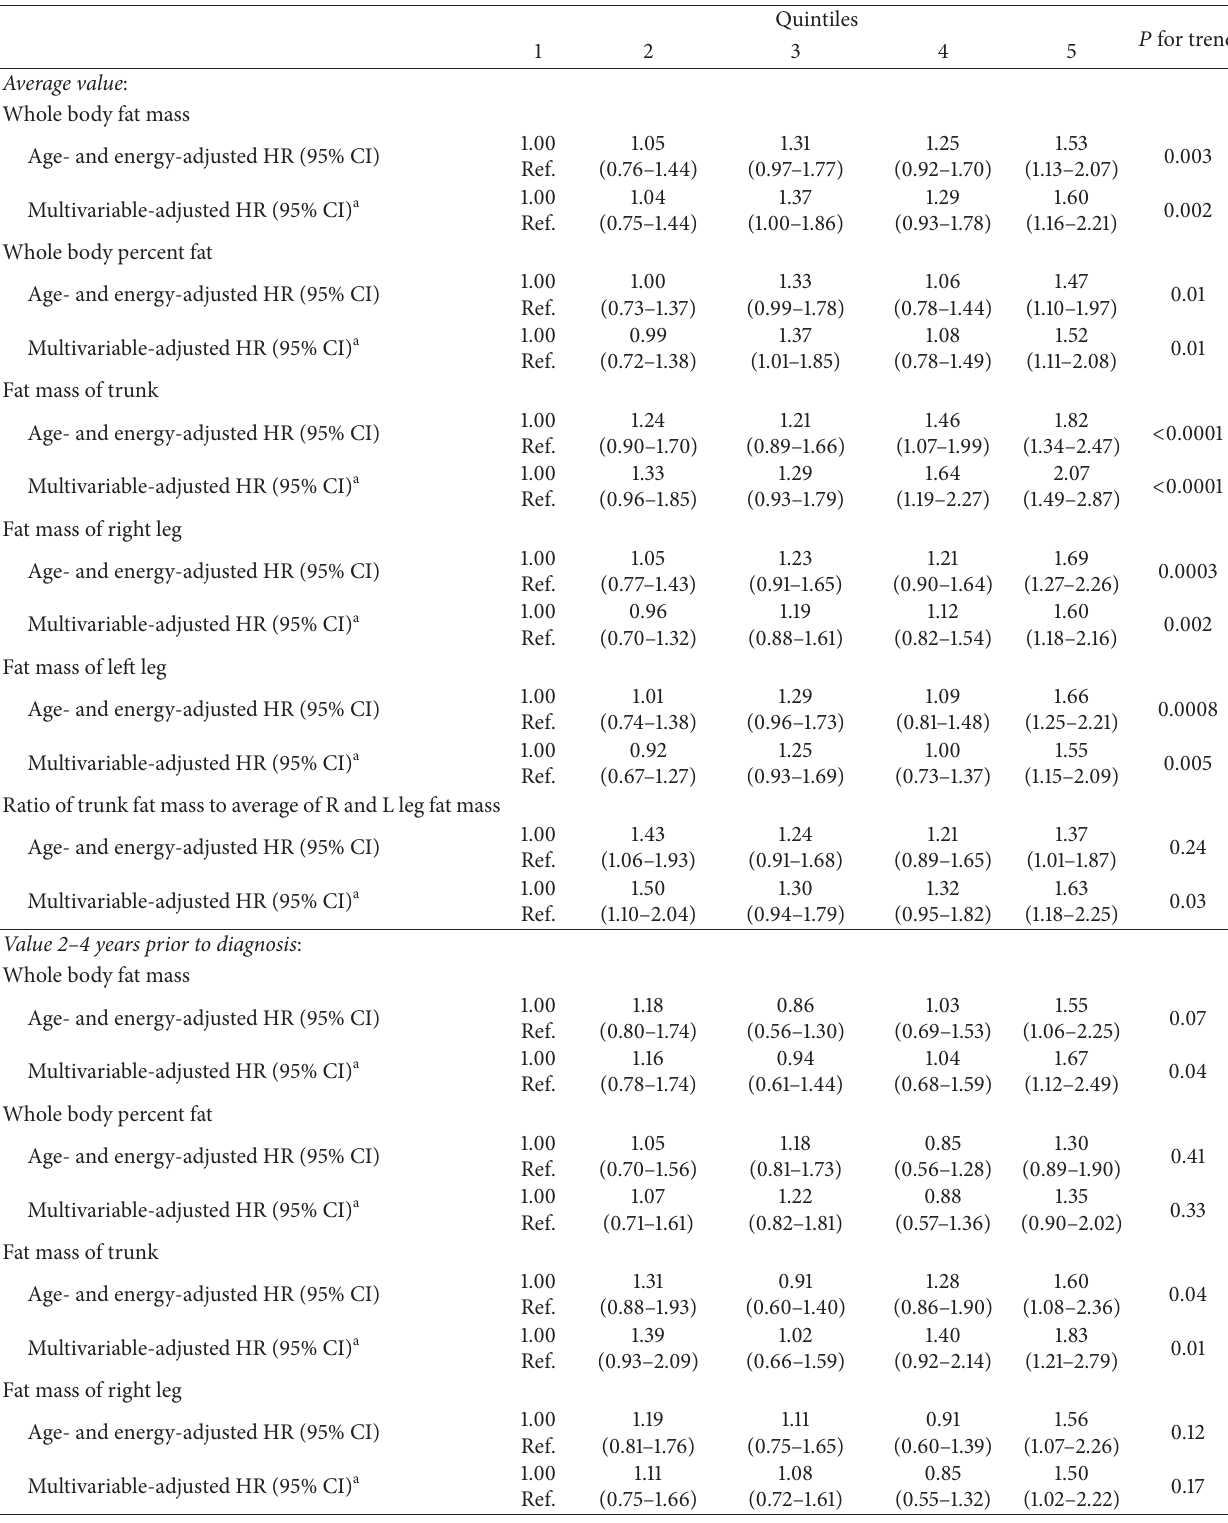
Table 5: Hazard ratios (HR) and 95% confidence intervals (CI) from time-dependent covariate analysis of the association of DXA-derived body fat with risk of incident, invasive breast cancer in postmenopausal